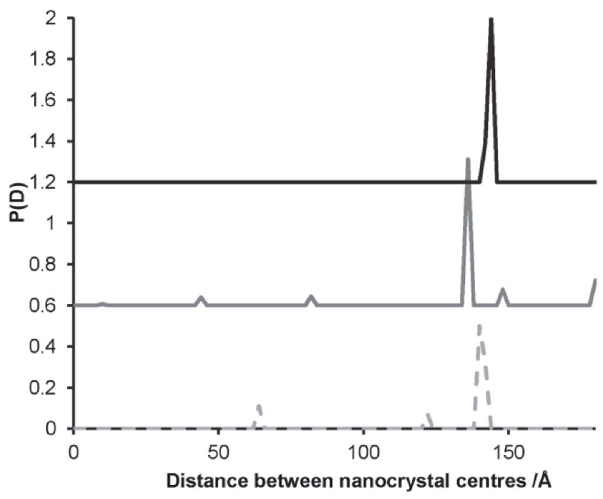
Figure 5. Probability distribution for the distance between nanocrystal centres for 50 base-pair DNA with gold nanocrys- tals at each end. Consecutive result sets are independent simulation runs; these are shifted vertically for clarity. Simulated errors in intensity were at 0.1% I (0) (set B) and the results shown are from the least squares